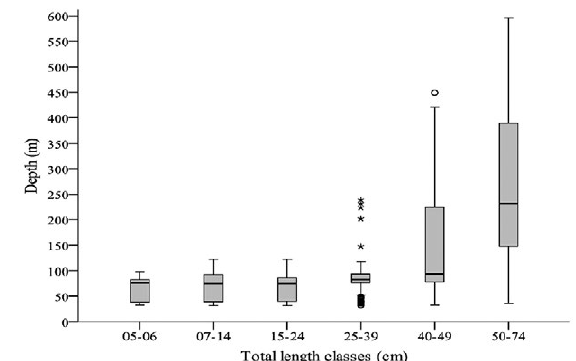
Fig. 2. – Spatial distribution of the samples of hake in the GoL in 2004-2006 (n=2483, min depth=31 m, max depth=596 m).